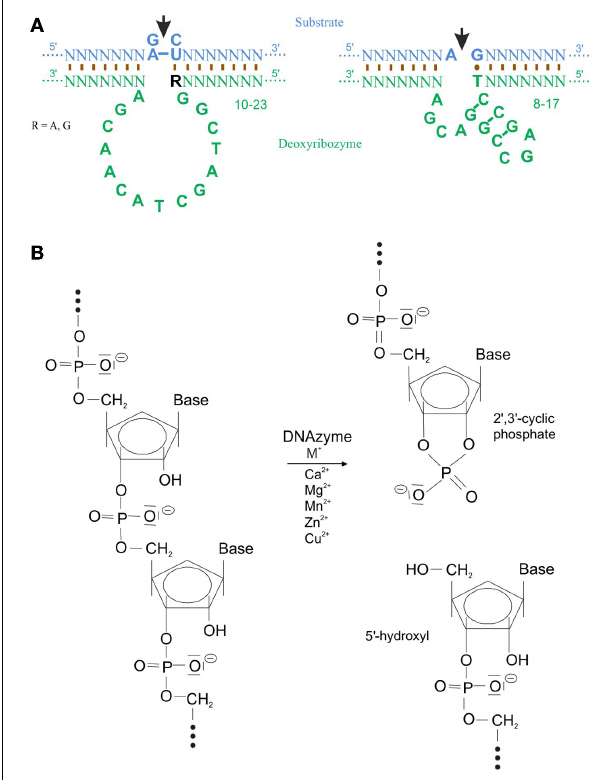
FIGURE 1 | Structure and digestion mechanism of deoxyribozymes. (A) Structure of the 10-23 and 8-17 deoxyribozyme.The catalytic loop digest the target mRNA (marked by the arrow) between an unpaired purine and a paired pyrimidine nucleotide. Binding to the mRNA occurs mostly via Watson–Crick base pairing. Note a G-T Hoogsteen base pair in the 8-17 deoxyribozyme (modified from Santoro and Joyce, 1997). (B) Transesterification of a target mRNA via a deoxyribozyme and divalent cations generates a 2 (cid:2) 3 (cid:2) -cyclic phosphate and a 5 (cid:2) -hydroxyl termini as end product (modified from Achenbach et al.,